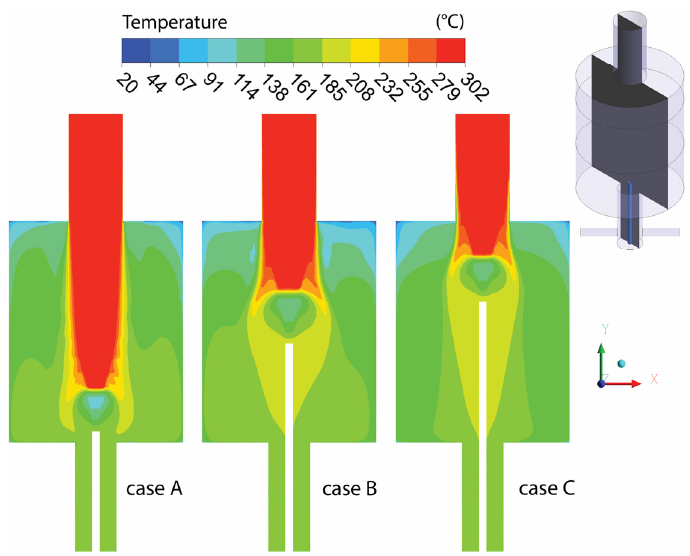
Figure 7. Temperature profile across the central axial cross-sectional plane (XY) for three different nozzle locations, A = 3 cm (left); B = 23 cm (middle); C = 33 cm (right).